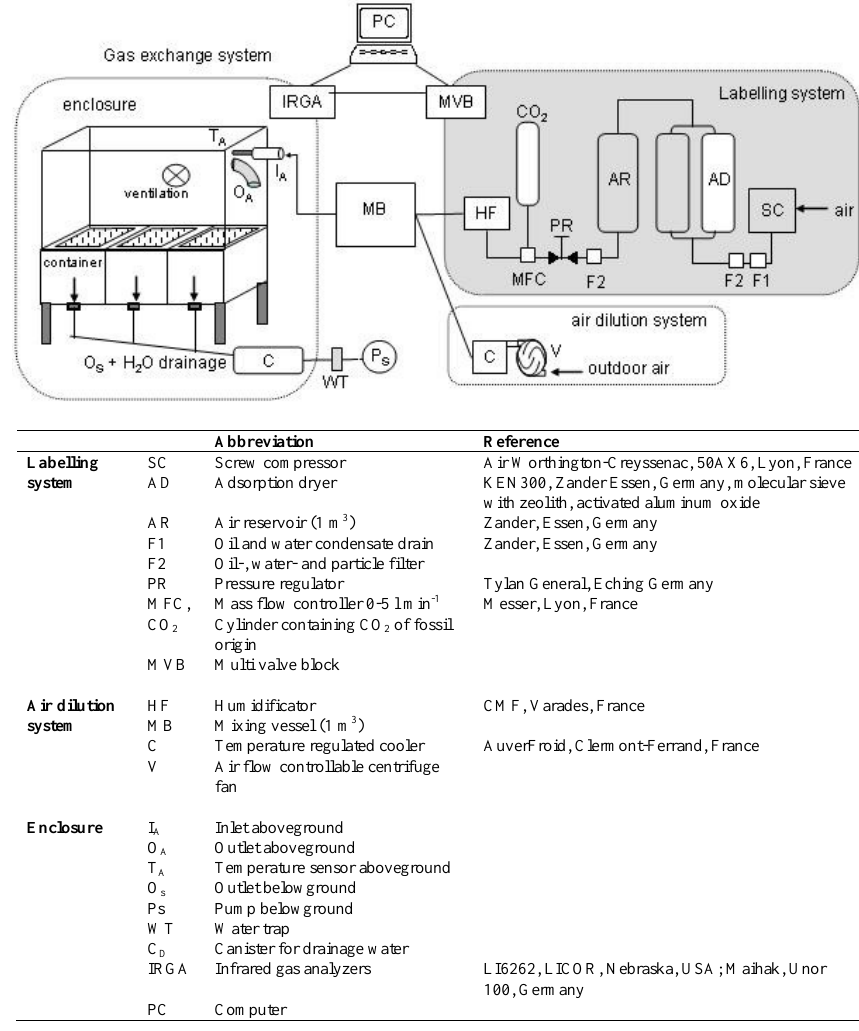
Abbreviation Reference Labelling Figure 1